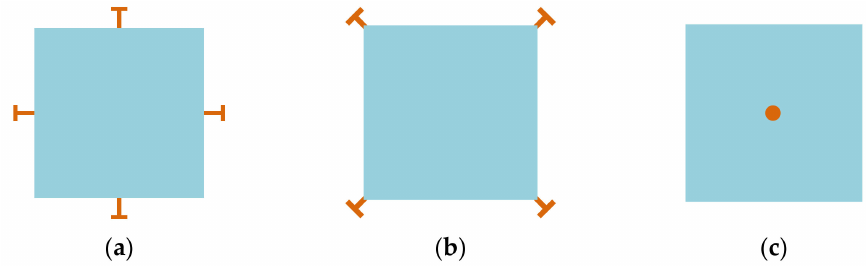
Figure 5. Suspensions at different positions: ( a ) On sides; ( b ) At corners; ( c ) At the center. A study on the resonators with a different number of suspensions [75], indicates that a BAW resonator can vibrate in the expected modes even with a minimum of two suspensions. The anchor losses generally are lower with a low number of suspensions. However, the resonance frequency also decreases with a small number of suspensions, as fewer suspensions result in a decrease in the effective